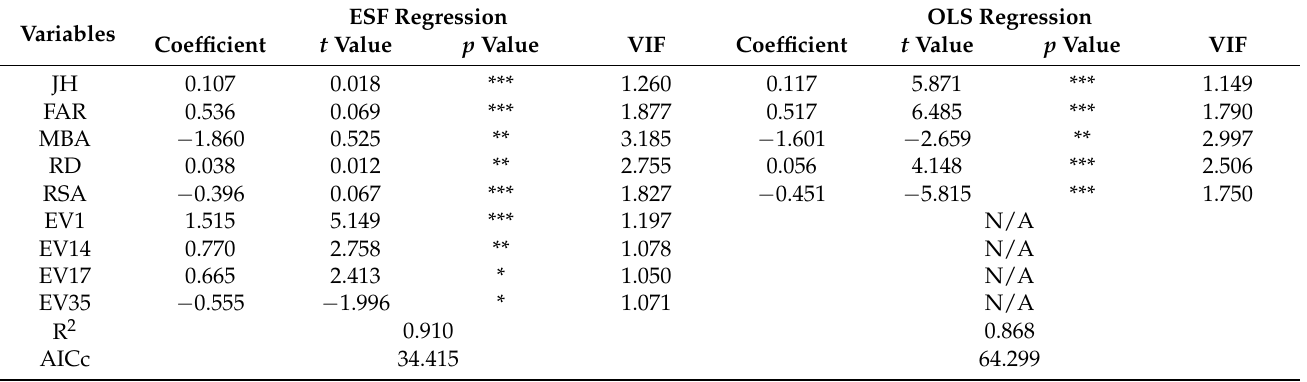
Table 7. Comparison of OLS regression and ESF regression (ln(Econ_V) as the dependent variable).